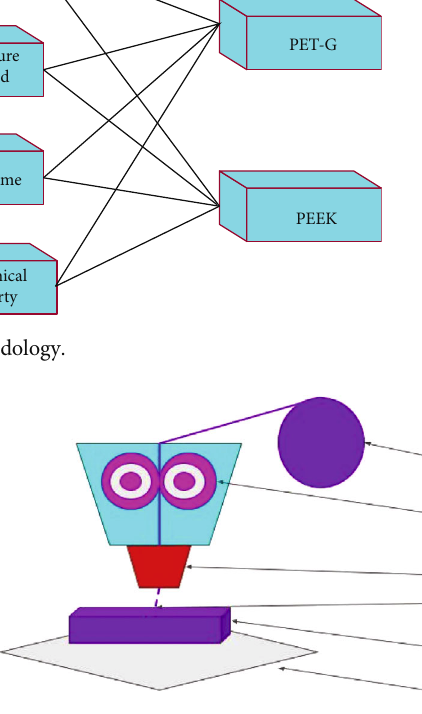
Figure 6: FDM components. Table 2: Time recorded for printing ASTM D638